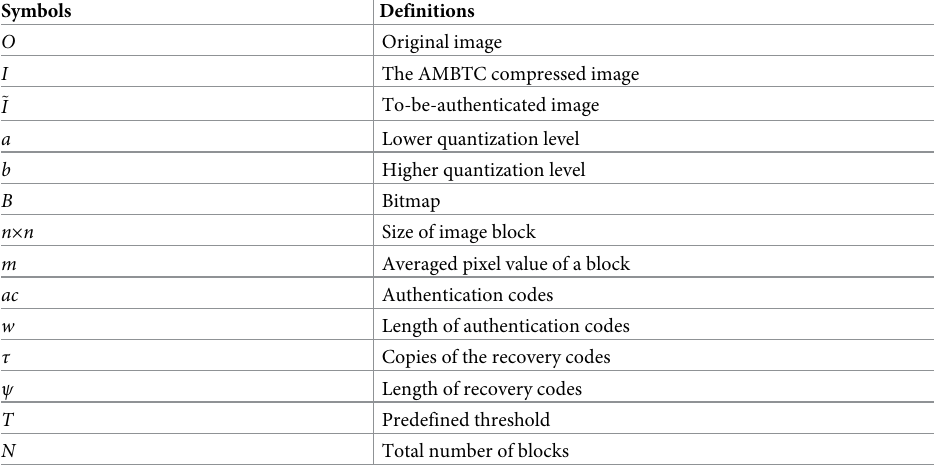
Table 1. Symbols used in this paper and their